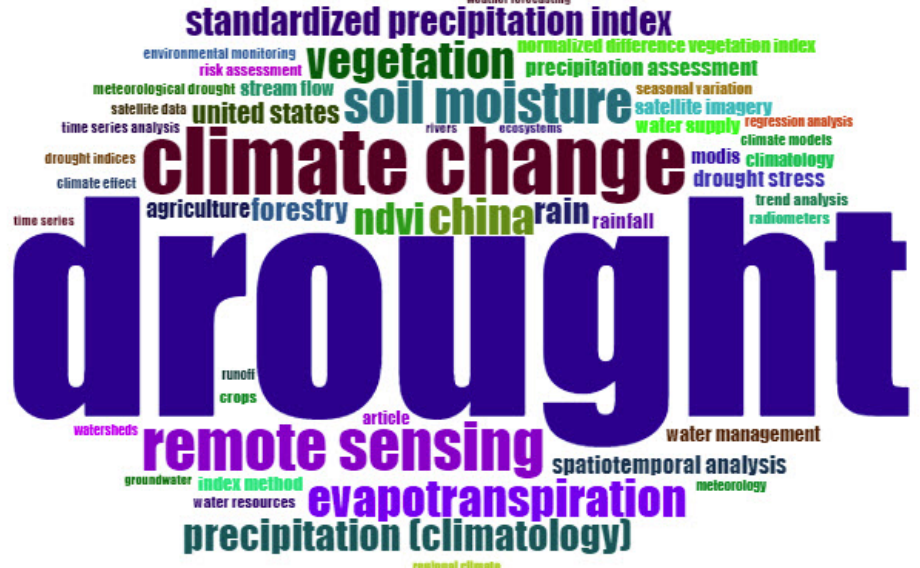
Figure 5. Word cloud for DIs in terms of keywords plus from 8294 merged DI publications.